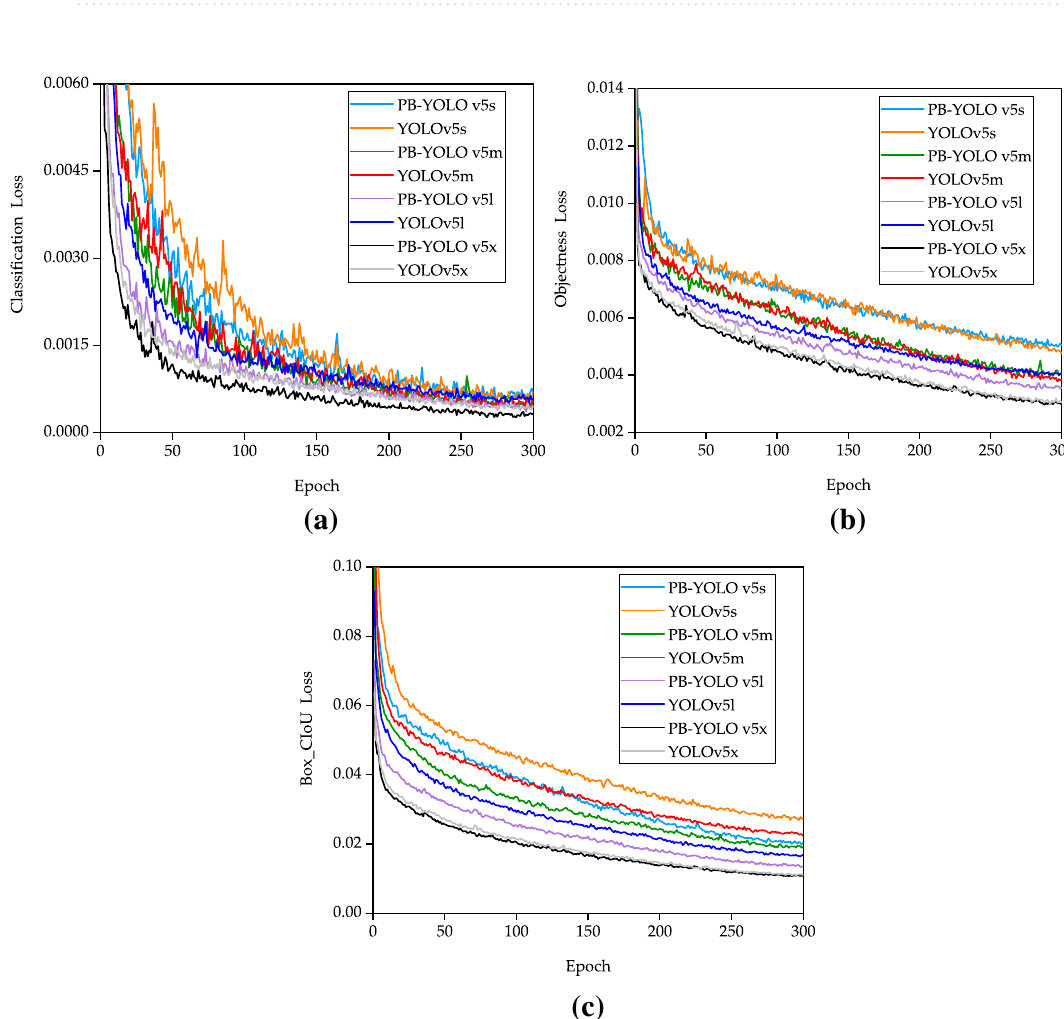
Figure 9. Comparison of loss functions under different models: ( a ) Classification loss curve, ( b ) Objectness loss (Confidence loss) curve, ( c ) Box_CIoU (Bounding box loss)